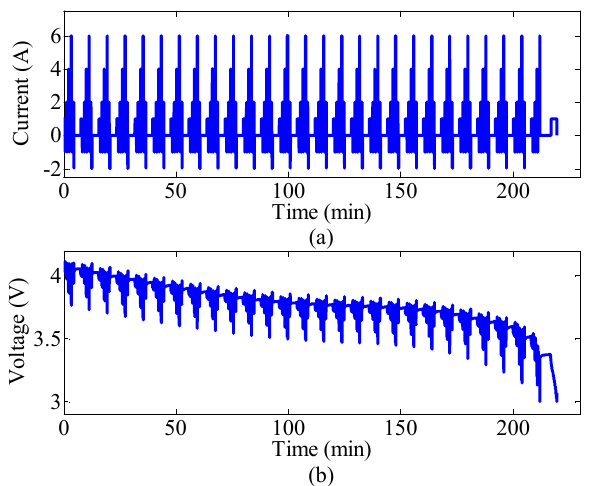
Figure 4. Dynamic stress test (DST) test at 25 °C in the sensor fault-free condition: ( a ) current profile; ( b ) voltage profile.